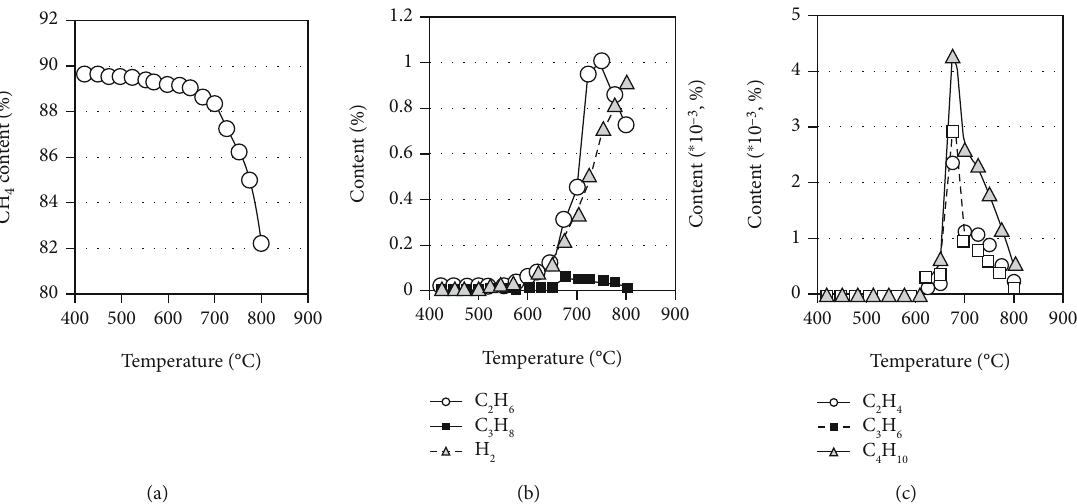
Figure 2: Concentration variation of hydrocarbon gases and H pyrolysis temperature. (b) Variation in C and C H contents with increasing pyrolysis. 4 10